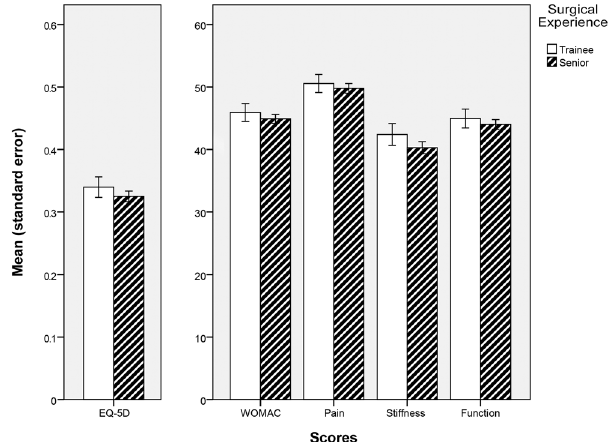
Figure 3. Improvement of patient reported outcome measures (WOMAC, EQ-5D) within the first year after THA in relation to surgical experience.